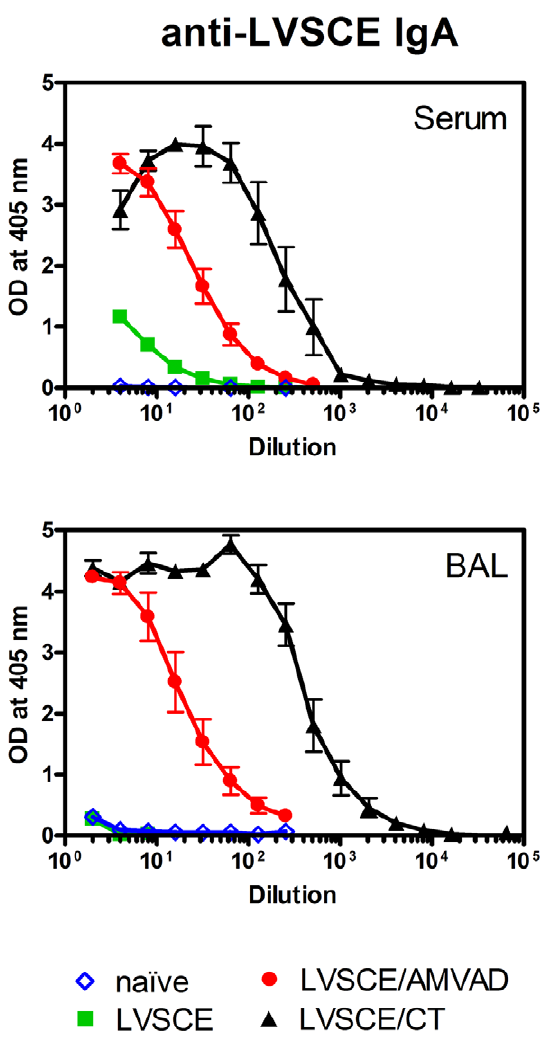
Figure 1. LVSCE/AMVAD vaccine induces strong LVSCE-specific IgA levels in sera and BAL fluids. Groups of female BALB/c mice (n=20) were immunized i.n. at 0, 7 and 21 d (1 m g LVSCE antigen, on total protein basis, per mouse per immunization) with LVSCE, LVSCE/ AMVAD or LVSCE/CT. A naı¨ve control group was also included. Five mice per group were euthanized at 28 d, for collection of sera and BAL fluids for LVSCE-specific IgA analyses by ELISA. Each data point represents the mean OD 6 SD for each group. Data are representative of two separate experiments.